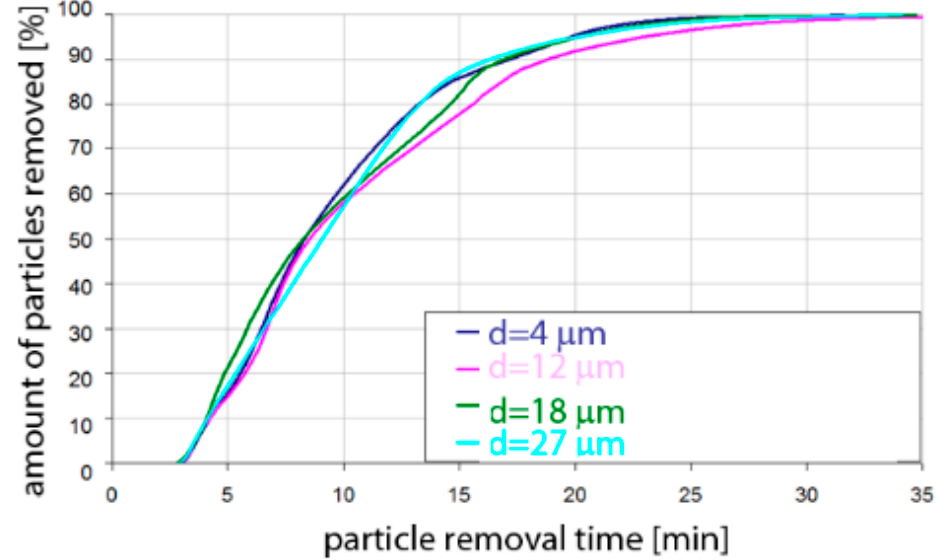
Figure 18. Share of removed non-metallic MnS inclusions from the analysed ladle in the case of argon flow of 50 L/min through the 18CrNiMo7-6 steel.